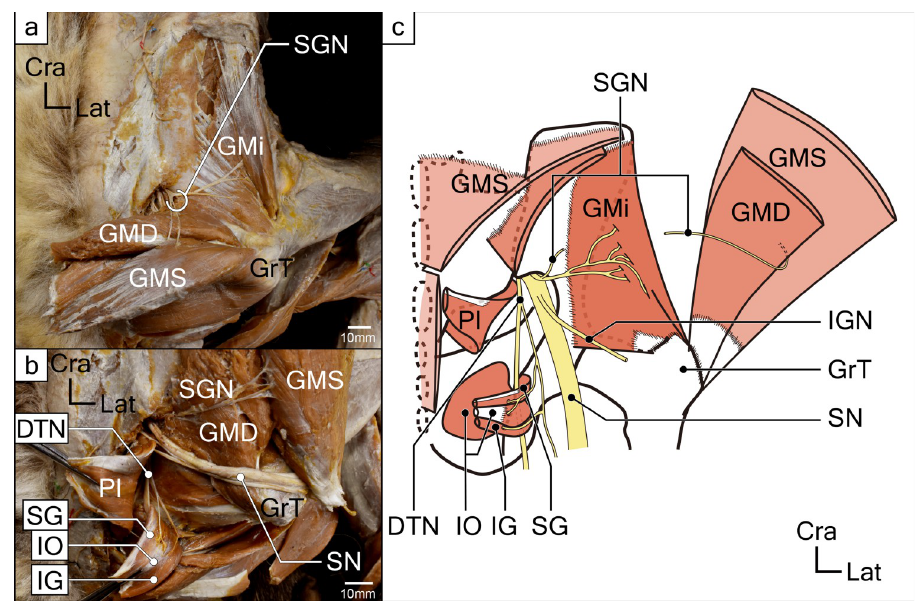
Fig 3. Deepest layer muscles of gluteus region and its innervations in koala right hip. ( a ) The superficial and deep layers of the gluteus medius (GMS and GMD), gluteus minimus (GMi), and the innervating branch from the superior gluteal nerve (SGN) are shown. ( b ) Gemellus and internal obturator muscles and supplying branch from the deep tibial nerve (DTN) are shown. ( c ) Schematic drawing of the deepest layer of gluteus muscles and its innervations. Abbreviations: DTN, deep tibial nerve; GlT, gluteal tuberosity; GMD, deep layer of the gluteus medius; GMi, gluteus minimus; GMS, superficial layer of the gluteus medius; GrT, greater trochanter; IG, inferior gemellus; IGN, inferior gluteal nerve; IO, internal obturator; PI, piriformis; SG, superior gemellus; SGN, superior gluteal nerve; SN, sciatic nerve.